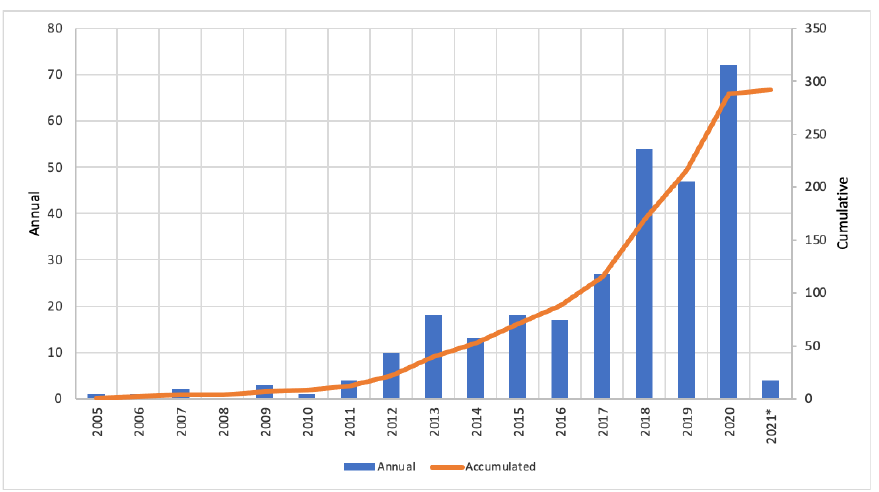
Figure 2. Reviewed studies by year (annual and cumulative). Source: Authors’ own elaboration. * forthcoming studies.